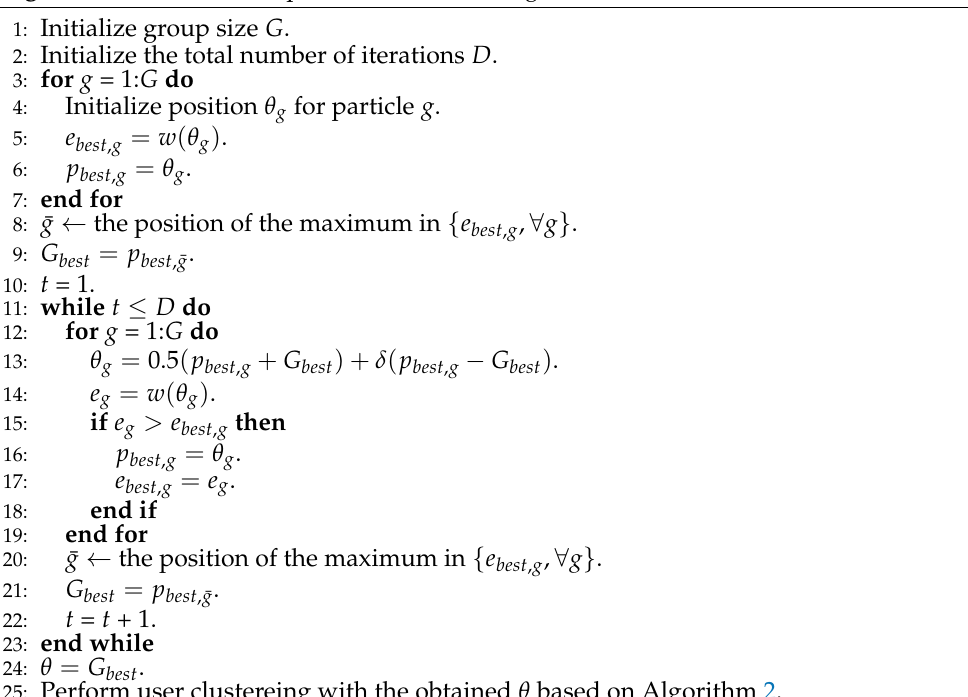
Algorithm 3 PSO-based Optimal User